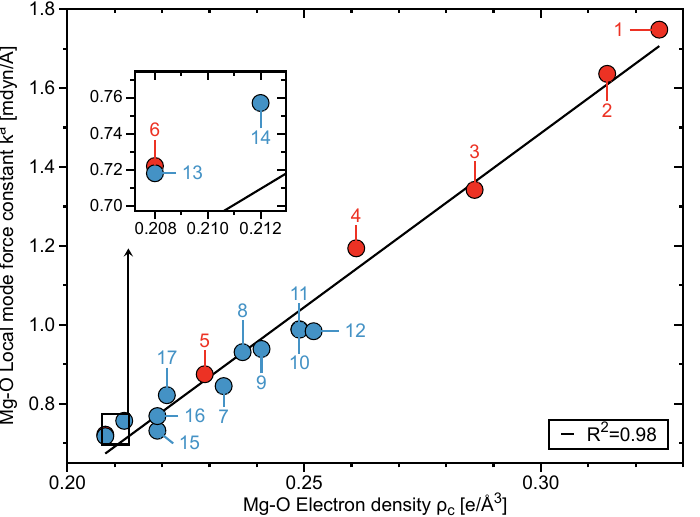
Figure 3. The Mg–O force constants k a versus the Mg–O electron densities ρ c for clusters 1 – 17 calculated at the ω B97X-D/6-311++G(d,p) level of theory. Clusters 1 – 6 are represented by red points and clusters 7 – 17 are depicted by blue